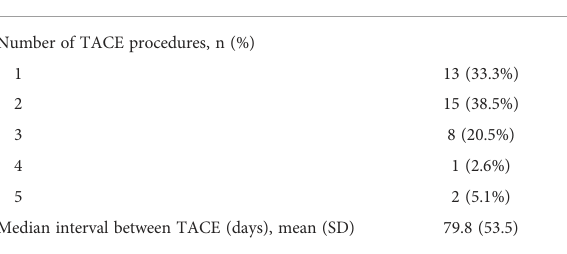
All patients (n=39)